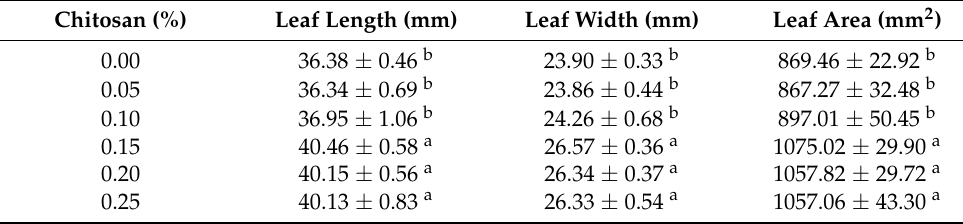
Table 3. Influences of chitosan soaking on leaf growth of P. grandiflorus plants.